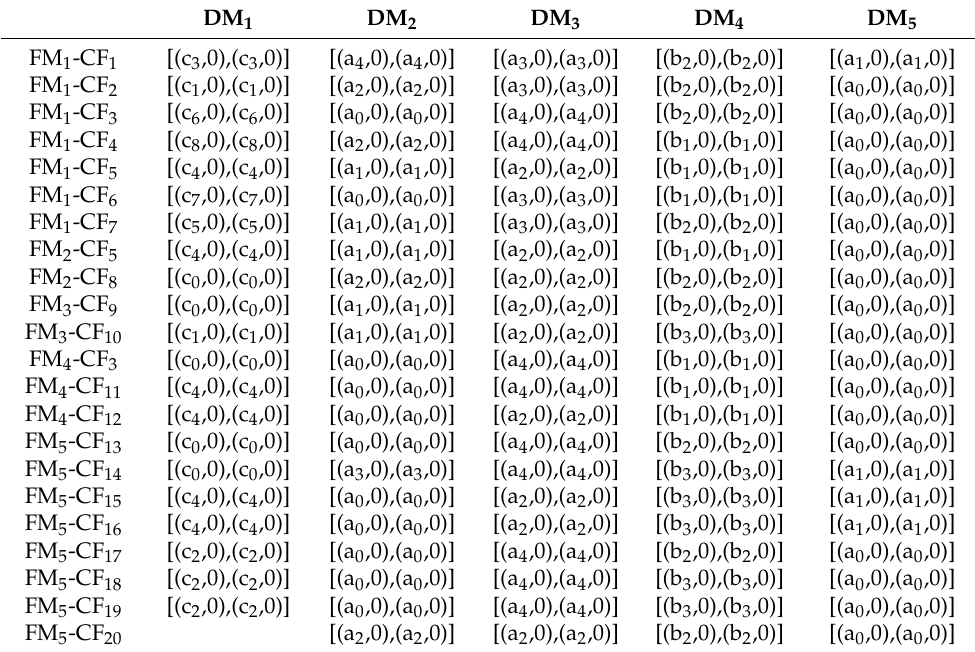
Table 4. Interval 2-tuple linguistic variables for Occurrence